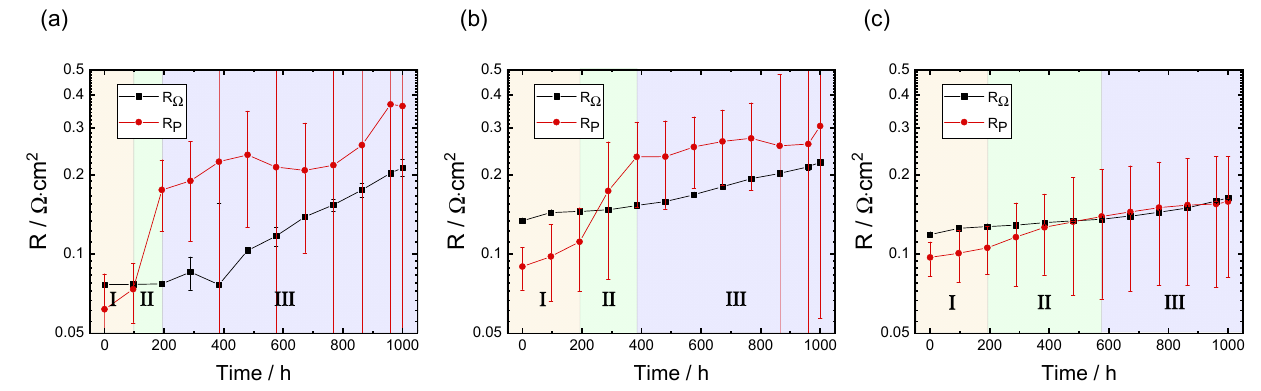
Figure 6. Development of R Ω and R P as a function of time measured at OCV for the gas composition ( a ) 800 °C 50% H 2 + 50% H 2 O, ( b ) 750 °C 50% H 2 + 50% H 2 O, ( c ) 800 °C 40% H 2 O + 40% CO 2 + 20% H 2 .